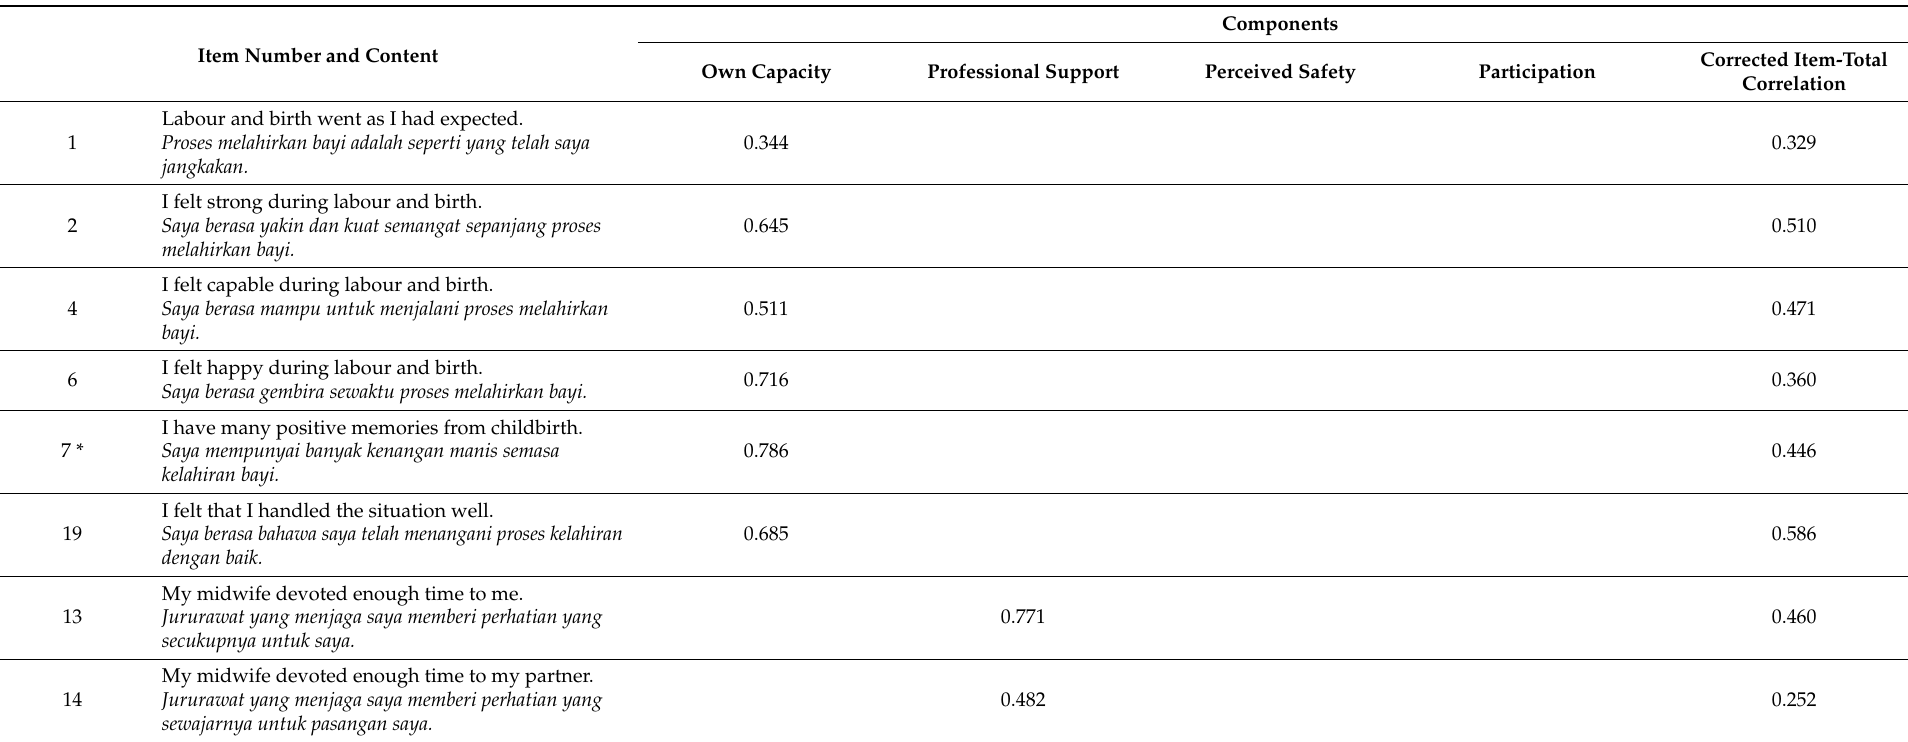
Table 2. Exploratory Factor Analysis (EFA) for 21 items of